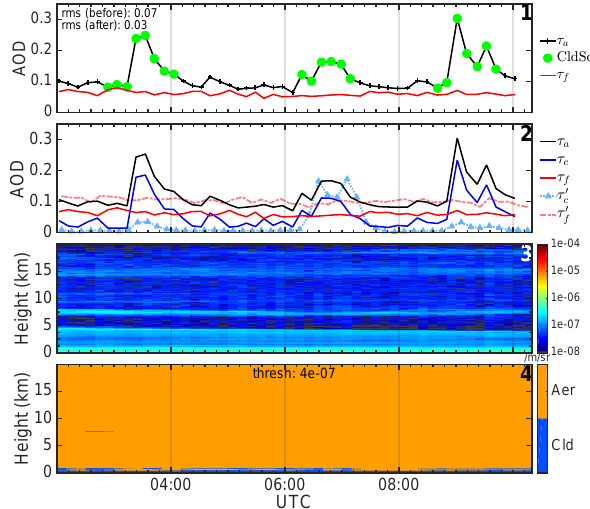
Figure 9. Cloud-screening illustration for the 10 March 2011 low- altitude ice crystal event. Pane 1: cloud points (green circles) that would be eliminated based on a temporal cloud-screening algorithm (see text for details); fine mode star photometry AOD (500nm) is reproduced for ease of comparison. The description of panes 2–4 is as in Fig.